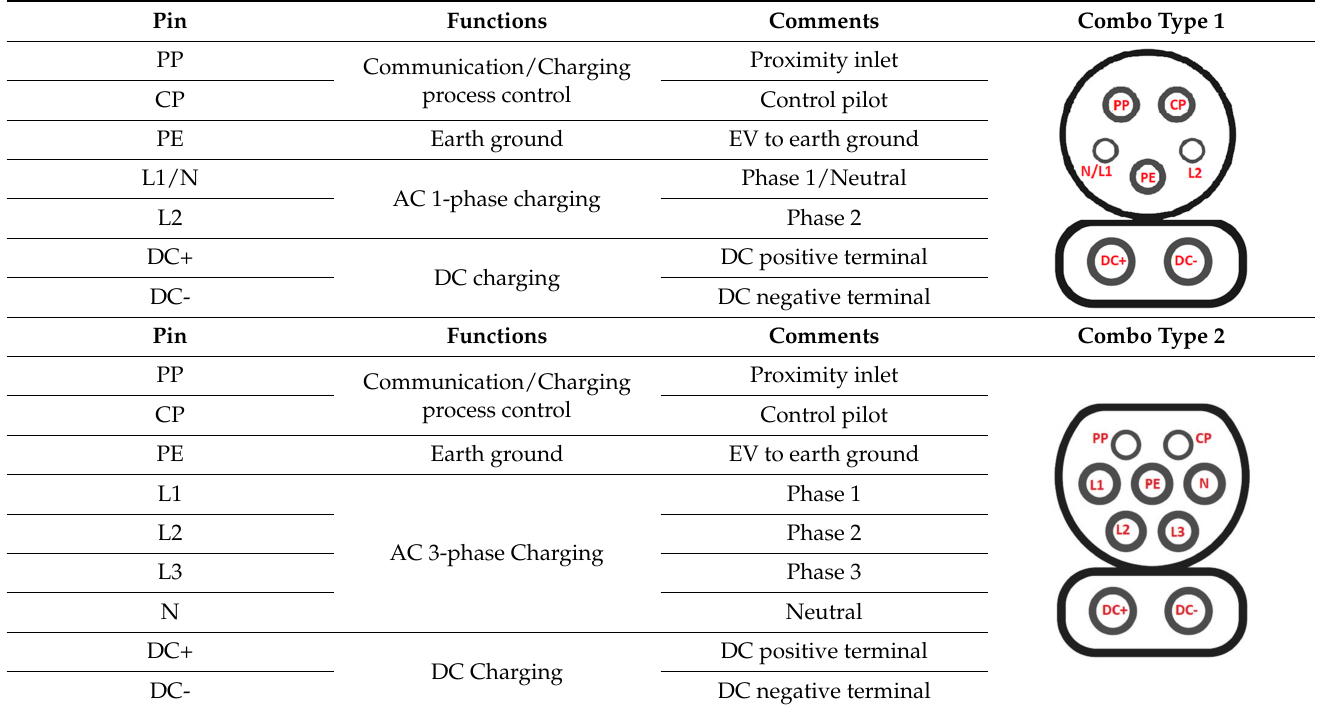
Table 6. Pin configuration and functionality of Combo connectors Type 1 and Type 2 [32].